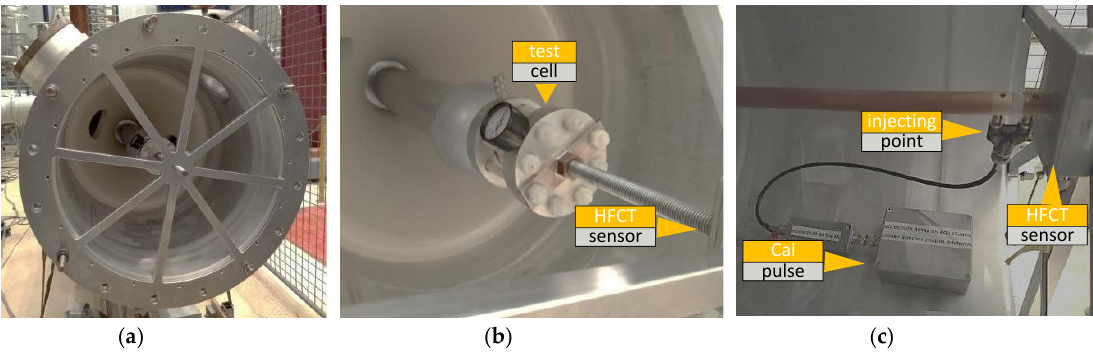
Figure 1. Test object indicating the location of ultra-high frequency (UHF) and high frequency current transformers (HFCT) sensors.